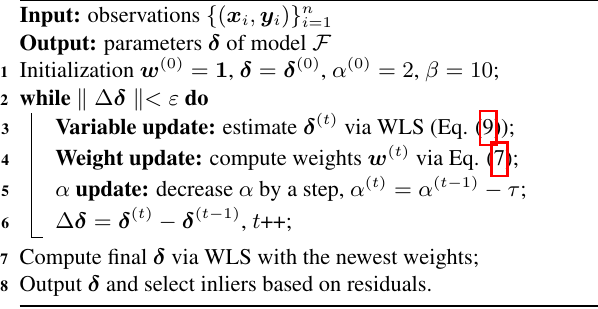
Algorithm 1: Robust estimation based on our robust